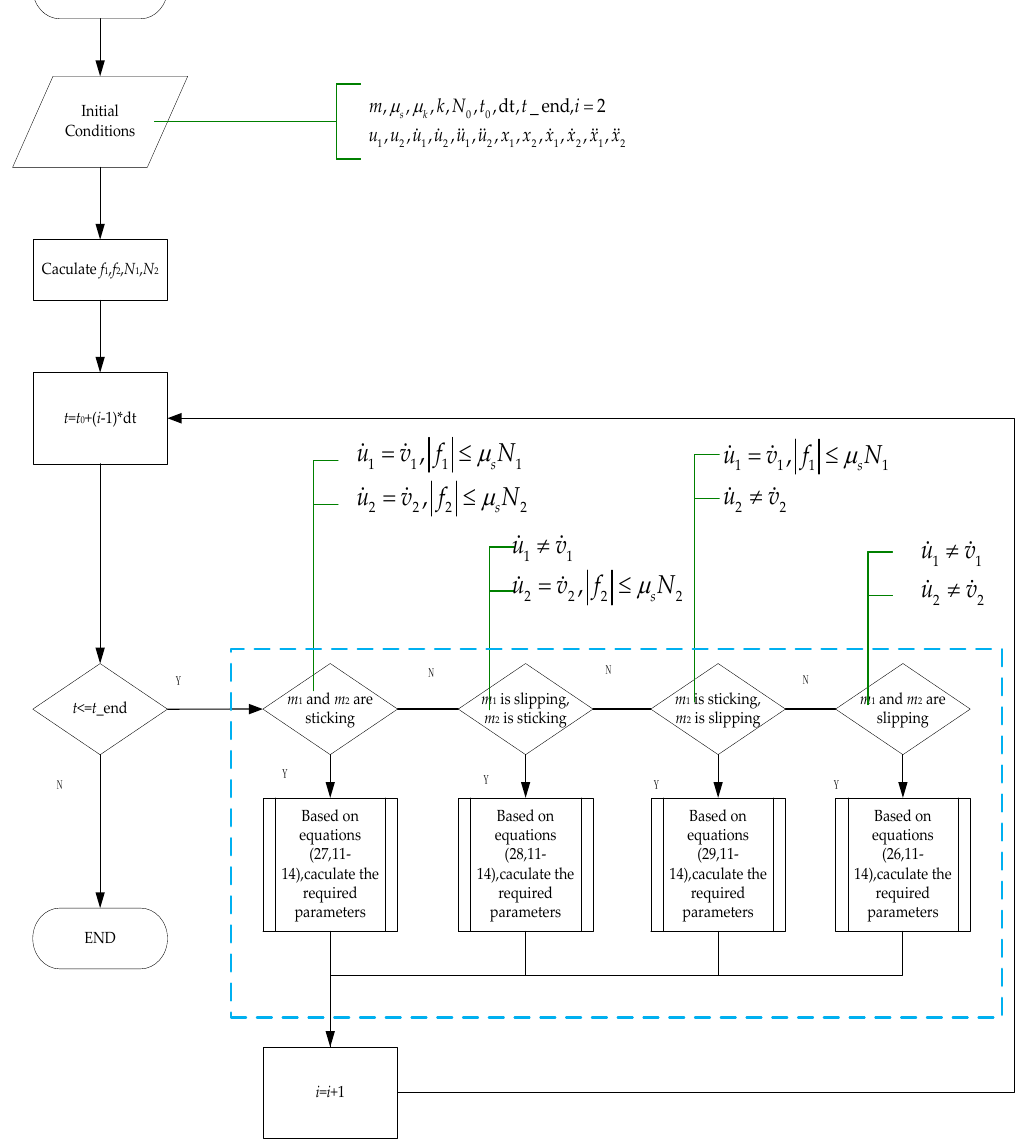
Figure 7. Flowchart for the numerical implementation in Matlab.